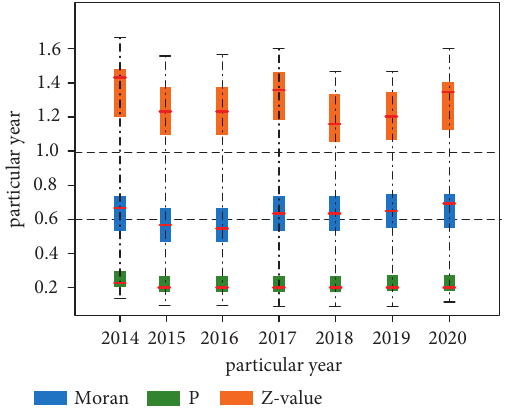
Figure 5: Empirical diagram of global spatial coefficient of GDP.